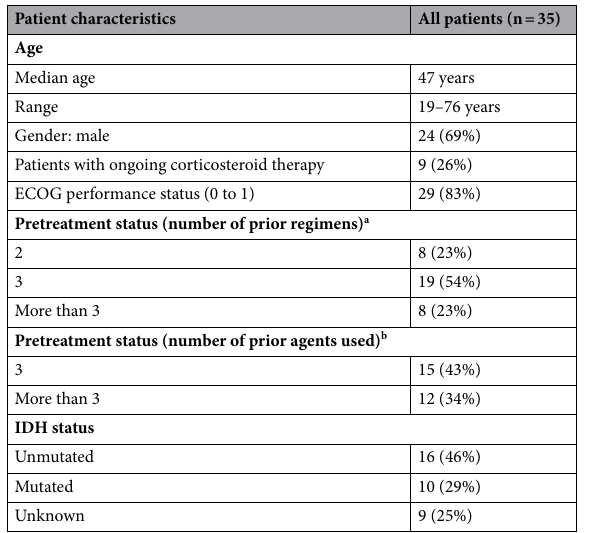
Table 1. Table illustrating patient characteristics. a All patients had progressed on at least one prior bevacizumab regimen, with 8 (23%) having progressed on two prior bevacizumab regimens. The median time to progression on prior bevacizumab therapy before study entry was 105 days. b All patients had at least 3 prior agents used before enrollment in the